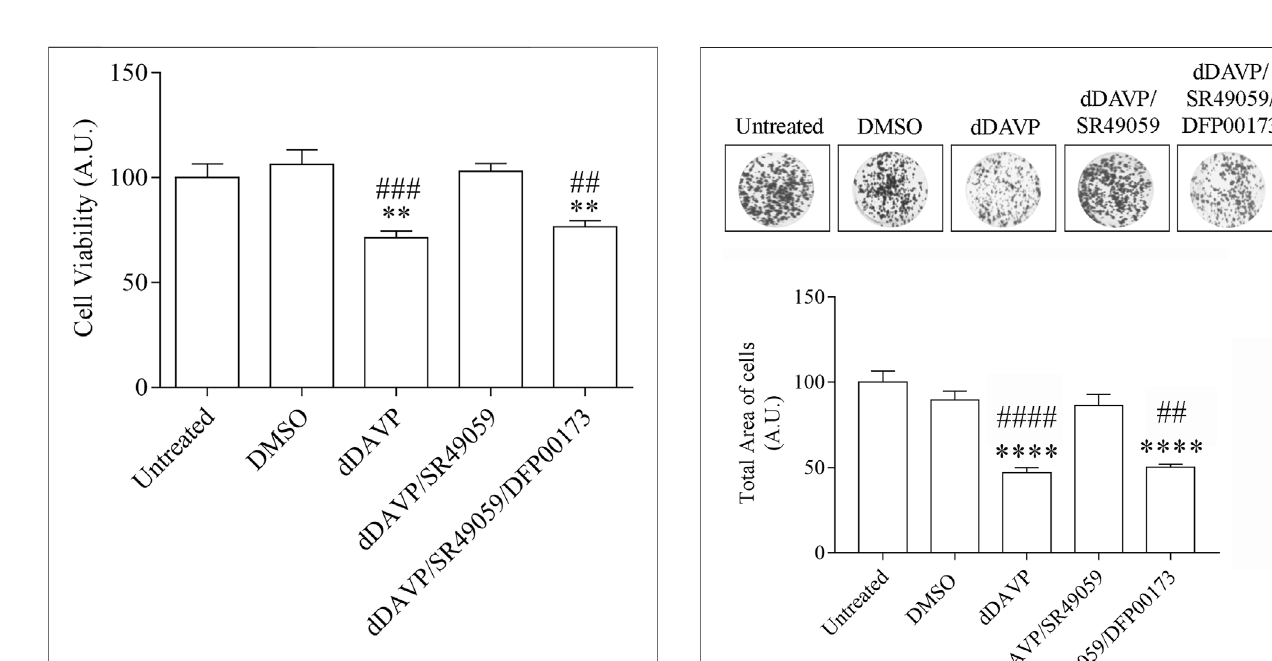
FIGURE 10 | Effect of AQP3 on cell viability. Cells were left under basal conditions or treated as described in the methods section and were stained with crystal violet solution. Compared to untreated cells, treatment with 2.5 µM DFP00173 for 48 h prevented the SR49059 action on dDAVP treatment. Data are presented as means ± S.E.M. of 6 independent experiments andanalyzedbyone-wayANOVA followed byDunnett ’ sMultiple Comparison test (** p < 0.01 vs. untreated; ## p < 0.01 and ### p < 0.001 vs. DMSO).